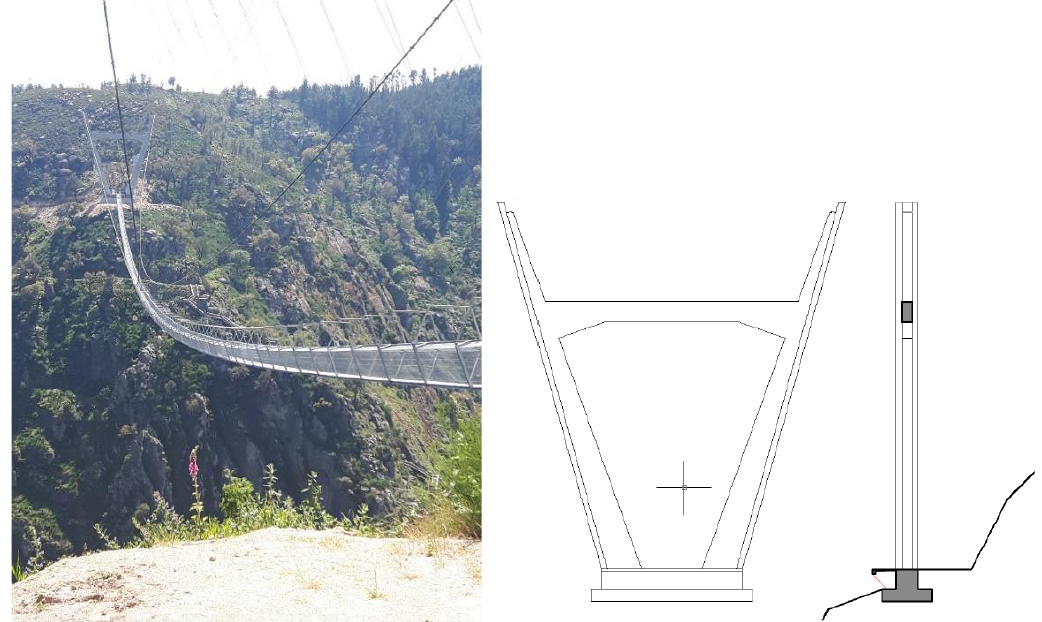
Figure 2. The 516 Arouca bridge and pillars geometry.